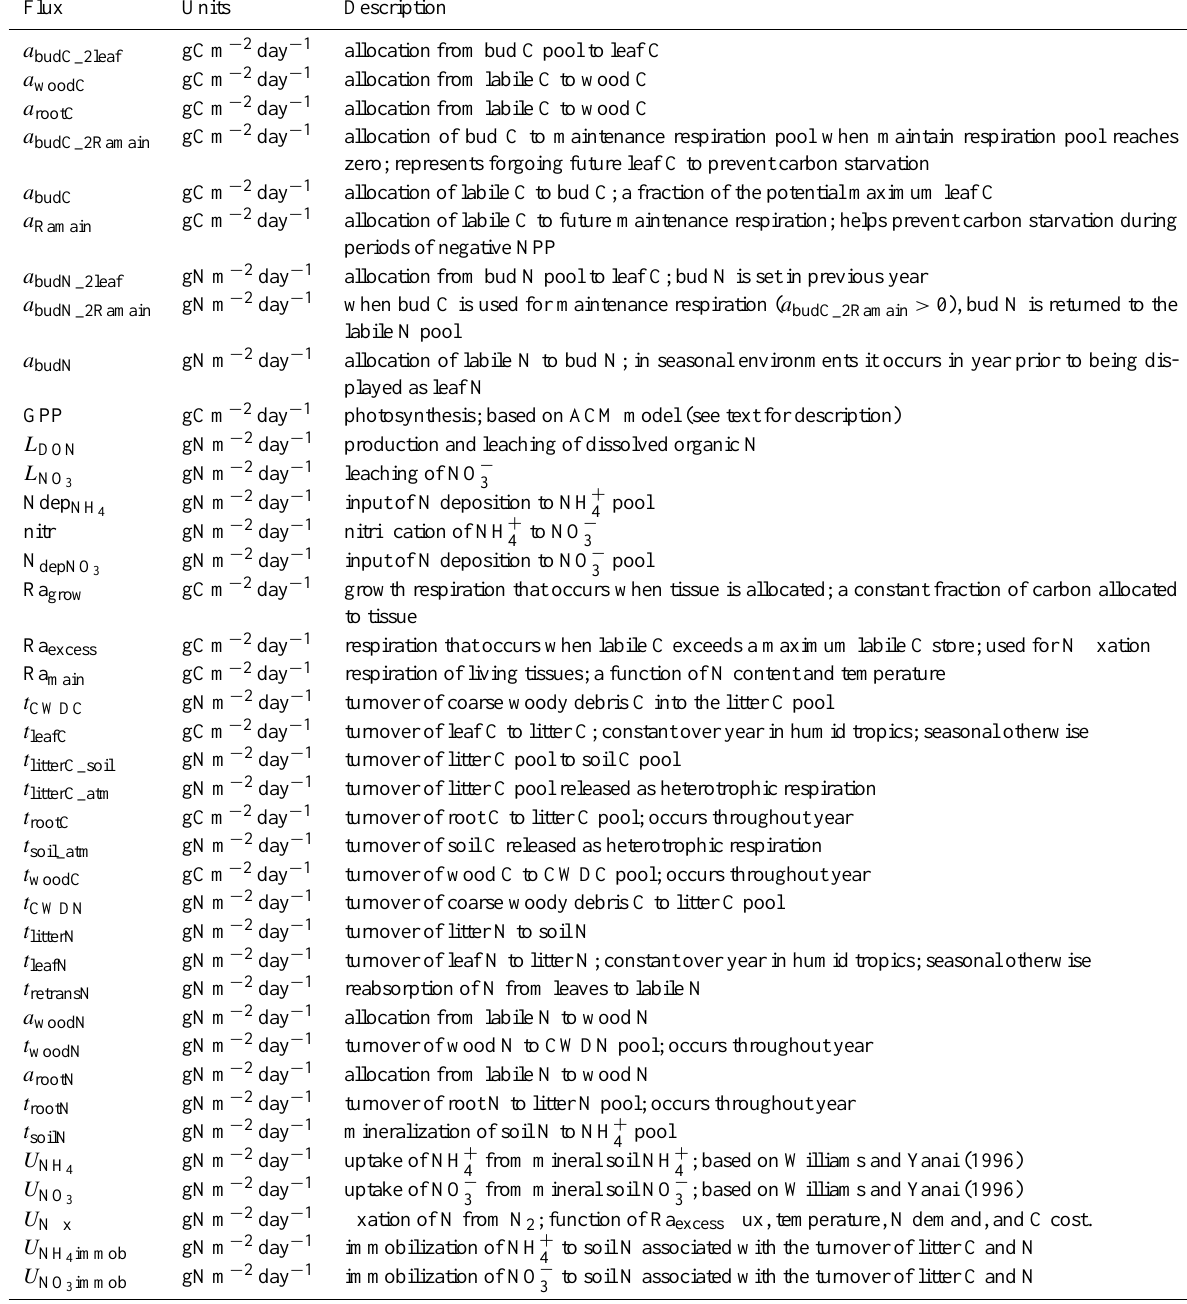
Table 2. Description of fluxes used in mass balance